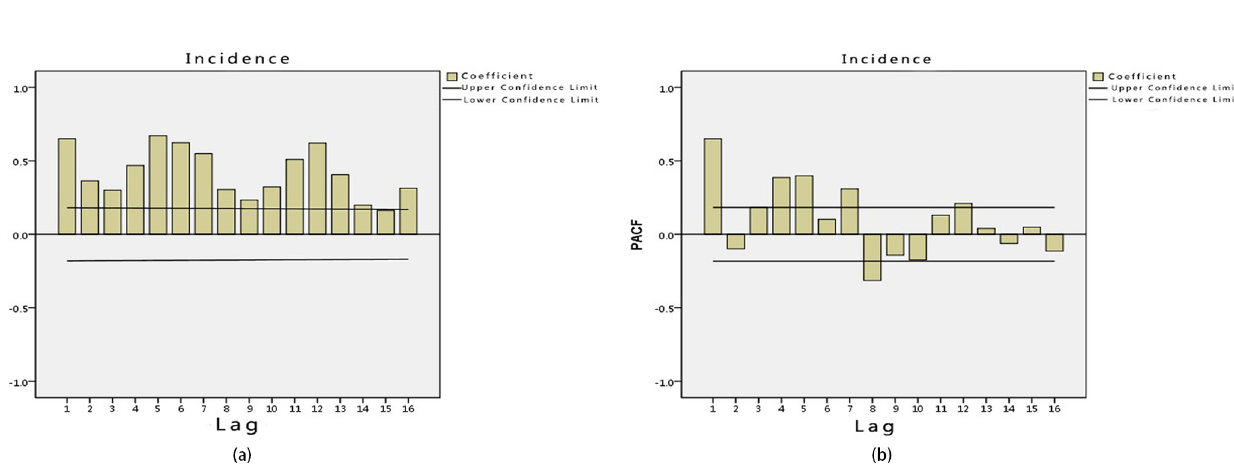
PLOS ONE | https://doi.org/10.1371/journal.pone.0207518 November26,